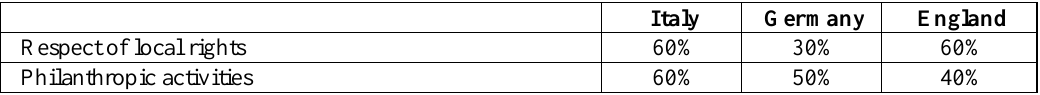
Table 9: Standard Behaviours in Relationships with Local